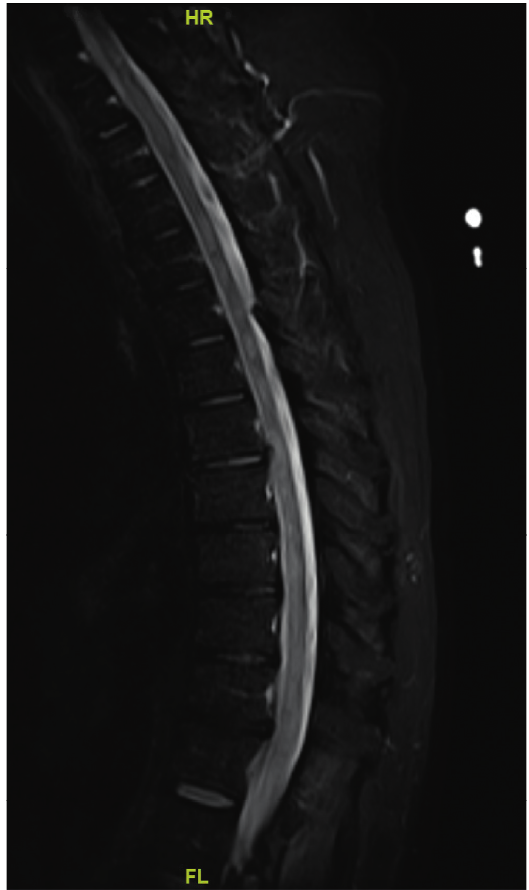
Figure 2: MRI spine T2-weighted sagittal image showing evidence of longitudinally extensive transverse myelitis